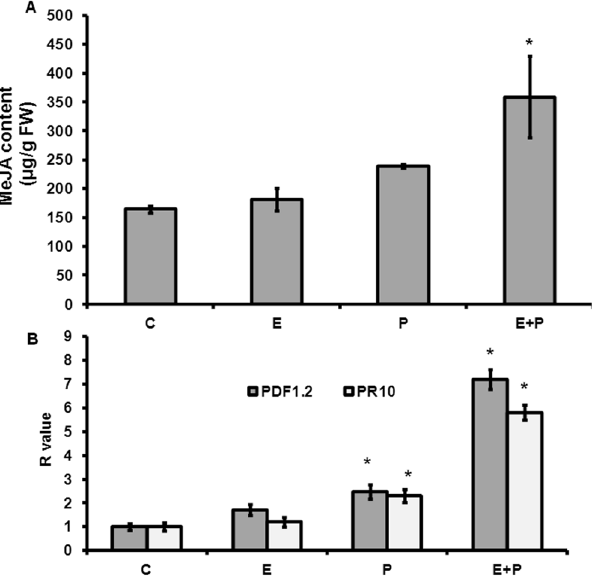
Figure 5. Quantification of jasmonic acid (JA) content and expression of JA responsive genes in Crocus corms. ( A ) Bar diagram shows JA content ( µ g/g fresh weight) in Crocus corms for all the four treatment conditions. ( B ) Transcript abundance of PDF 1.2 and PR10 genes in Crocus corms. where, C means control (endophyte free plants), E means only endophyte (CS10E4) treatment, P means only pathogen ( F. oxysporum R1) treatment and E + P means pathogen treatment 3dpi of endophyte. 18 S was used as the internal reference gene. Data are means ± SD from three biological replicates. * Represents significance at P ≤ 0.05 using GraphPad InStat tm software